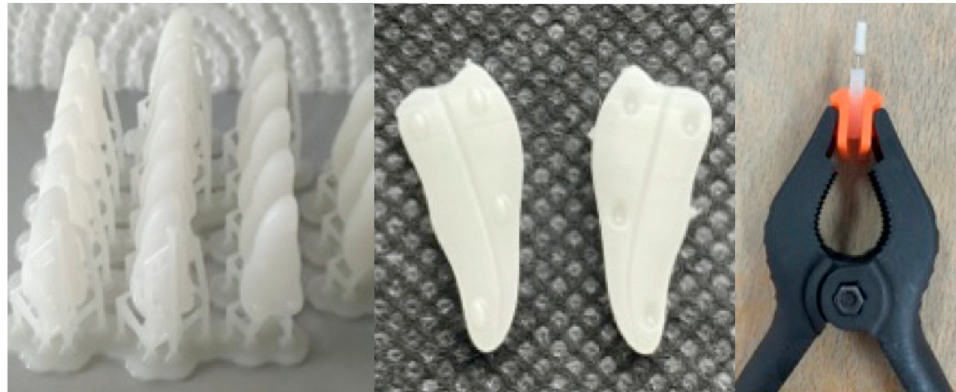
Figure 1. Dental replicas after the printing process. The two halves of the printed dental replica with the simulated curved root canal. Sticking of the two halves of the dental replica.